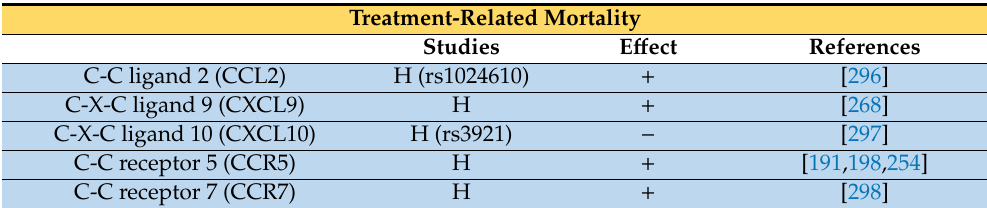
Table 6. Treatment-related mortality (TRM) in humans (H). See the Methods section regarding the reporting of results (Section